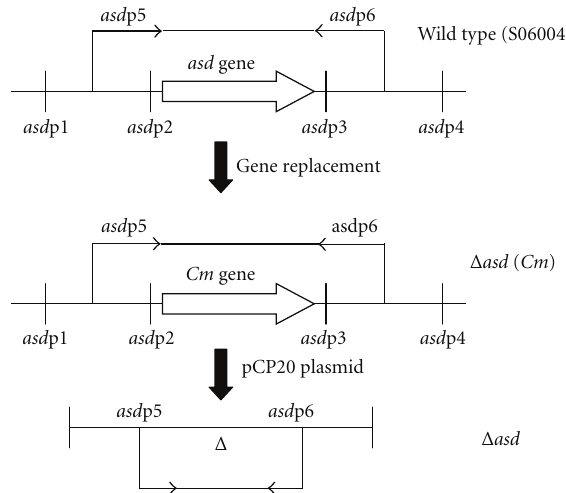
Figure 3: Genetic organization of a recombinant construct con- taining a defined deletion. The map shows the recombinant Δ asd (1488bp) region deleted from the SP genome. The open arrow indicates the coding region of the asd gene ( Cm R gene), and dotted lines represent the limits of the deleted region. The deletion is shown as an open triangle, and the sizes of the flanking regions adjacent to the deletion on the suicide vector are indicated. The position and orientation of PCR primers used in this study are indicated by filled arrows on the map of the wt DNA. The sizes of the PCR amplified products from the wt, the SP Δ asd ( Cm ) mutant, and the SP Δ asd mutant are 1796 bp, 1360 bp, and 328 bp, respectively.